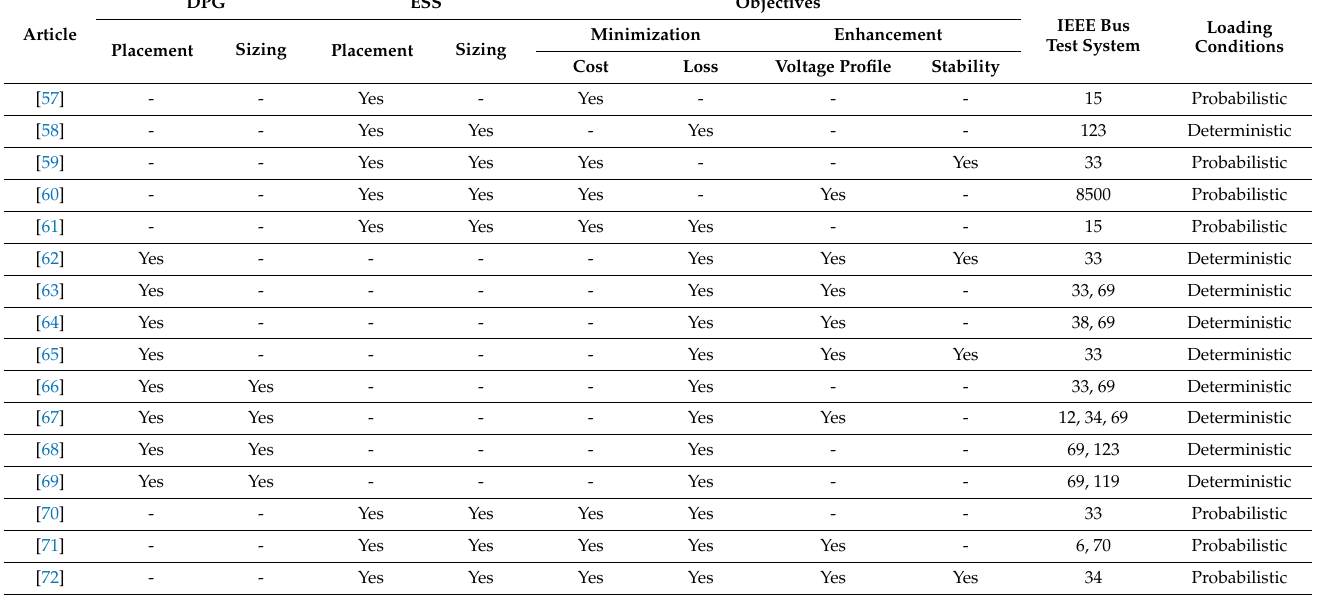
Table 4. ( a ) Considerations of constraints for optimization modeling. ( b ) Comparative analysis for DN planning.